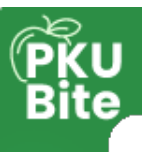
Figure 2. ‘ PKU Bite ’ ®